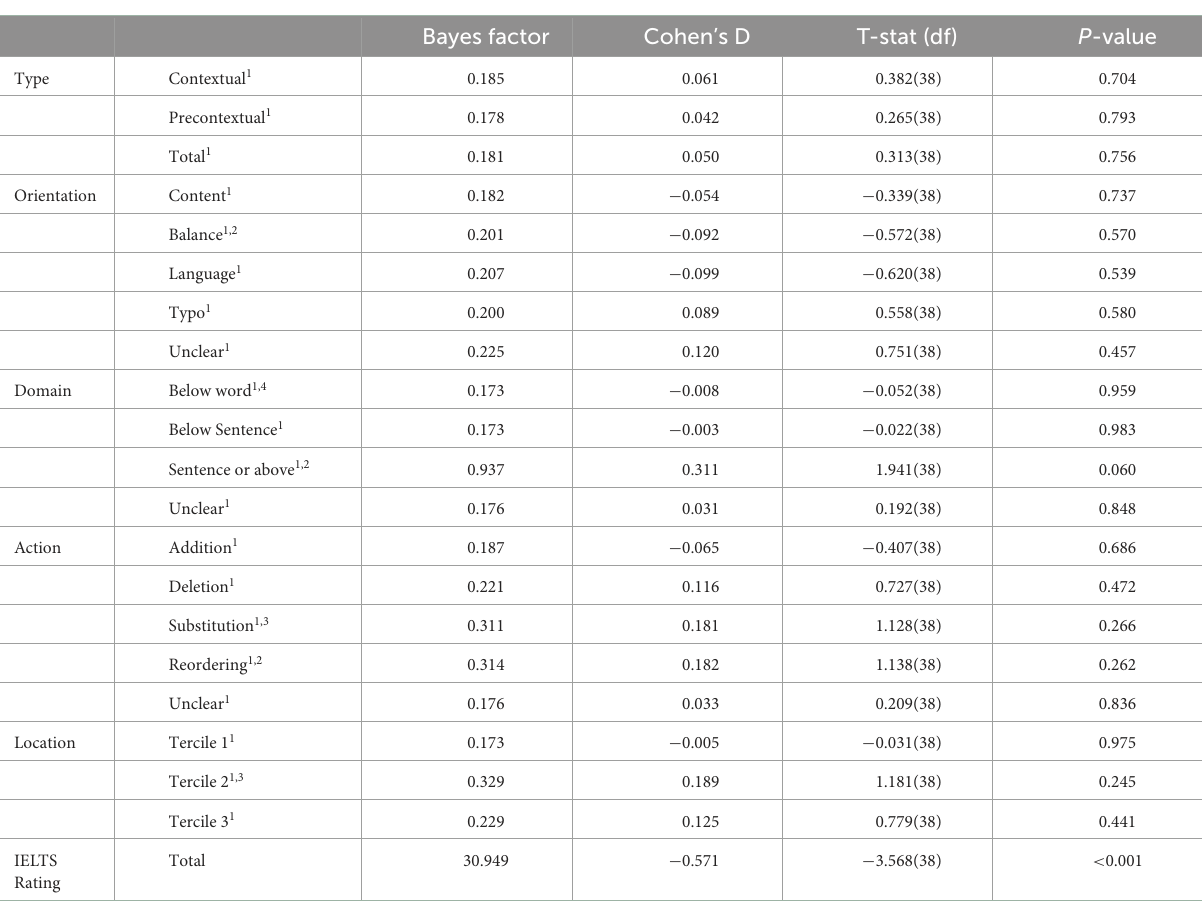
TABLE 4 Paired t -test information